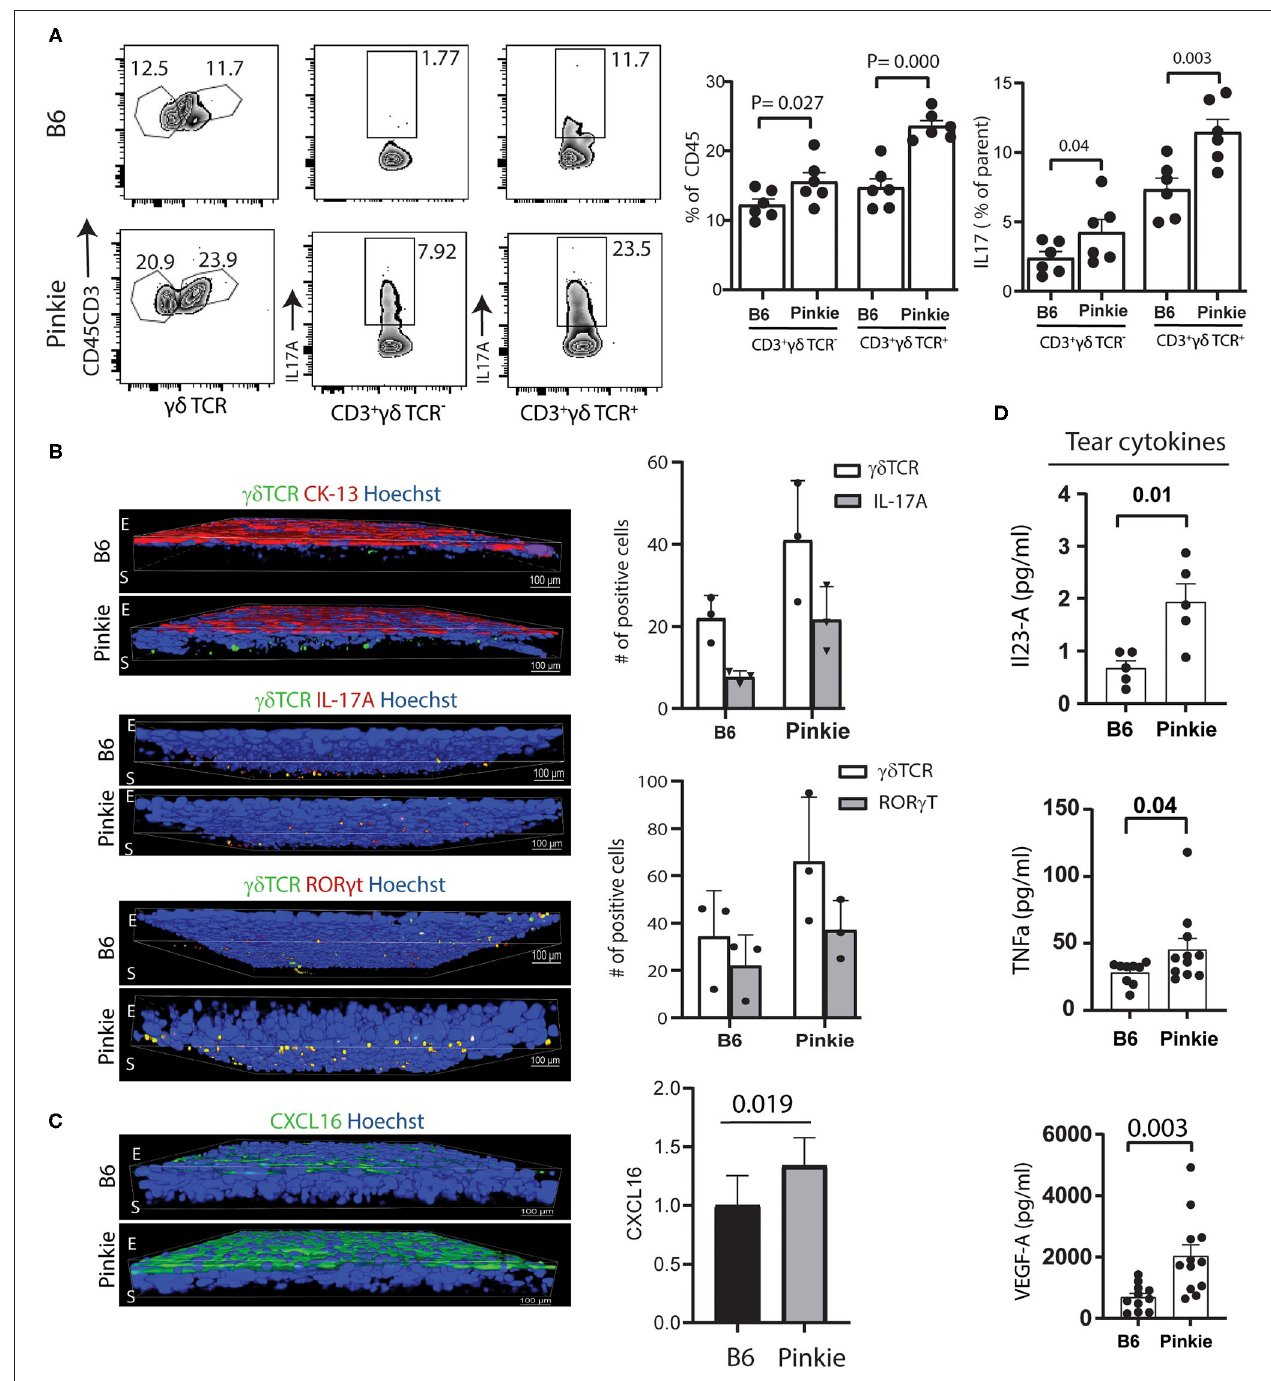
FIGURE 3 | Increased γδ T cells in the Pinkie conjunctiva. (A) Flow cytometry of γδ T cell receptor positive cells ( γδ TCR) left, IL-17A + CD3 + γδ TCR- center and IL-17A + CD3 + γδ TCR + right [C57BL/6 (B6) strain top and Pinkie strain bottom] Bar graphs show the mean + /– SD of the percentage of cells in these groups ( n = 6/group). (B) Confocal microscopy of whole-mount conjunctivas obtained from B6 and Pinkie (age 8–10 weeks) costained with antibodies specific for γδ TCR and conjunctival specific cytokeratin 13 (CK-13) (top), IL-17A (middle), and γδ T cell transcription factor ROR γ t (bottom) ( n = 3 per group). The number of γδ T cells positive for IL-17A and ROR γ t are shown in the bar graphs to the right. Antibody details are provided in Supplementary Table 2 . E, epithelium; S, stroma. (C) Confocal microscopy of whole-mount conjunctivas obtained from B6 and Pinkie (age 8–10 weeks) stained with CXCL16 antibody (left, n = 3). Minimal staining was observed in the B6 conjunctival. Comparison of CXCL16 expression level (fold change) in the conjunctiva measured by real-time PCR (right, n = 6). (D) Tear concentrations of IL-17 signature cytokines IL-12A/IL-23A (top) and TNF-a (middle), and angiogenic factor VEGF-A (bottom) measured by Luminex multiplex assay ( n = 5–12/group, age 8–10